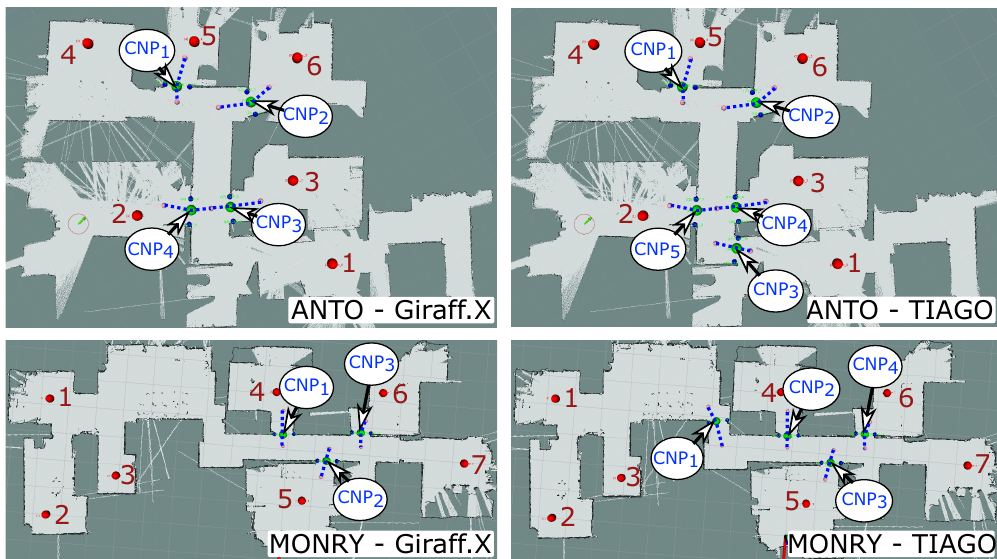
Figure 7. Illustration of how different robot shapes lead to the detection of different CNPs in the environment. Nodes are displayed as red dots and numbered according to the order used in the experiments, CNPs have been explicitly marked and numbered according to the order they are created during the experiments, and ANPs are marked with a blue-dash line that joins the two ANP belonging to the same